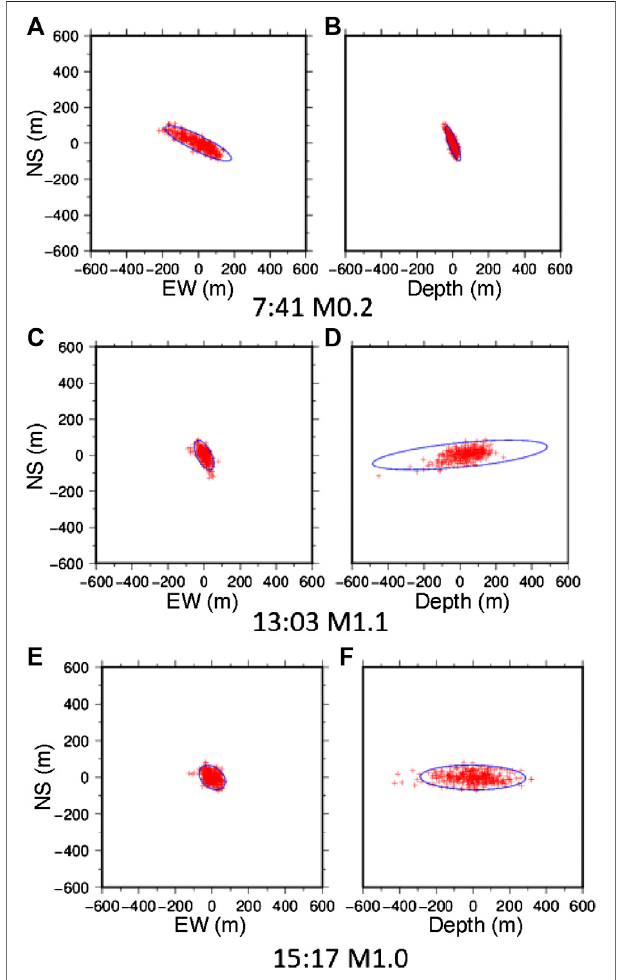
FIGURE 6 | Examples of the hypocenter distributions obtained by the bootstrap resampling method. Red cross marks and blue ellipses represent the hypocenters and the 95% con fi dence interval ellipses, respectively. (A) and (B) show the results for the event on 7:41 JST with M (cid:1) 0.2. (C) and (D) showtheresultsfortheeventon13:03JSTwithM (cid:1) 1.1. (E) and (F) show the results for the event on 15:17 JST with M (cid:1) 1.0. (A) (C), and (E) show the results for horizontalplanes. (B) (D), and (F) show the results forNS tovertical cross sections. It is worth noting how the hypocenter distribution and con fi dence ellipse of the different earthquakes differ.